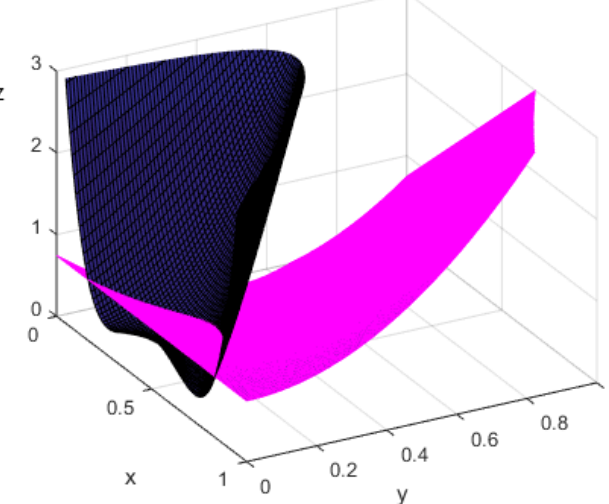
Figure A3. Curve τ as intersection of the two surfaces in the strategy